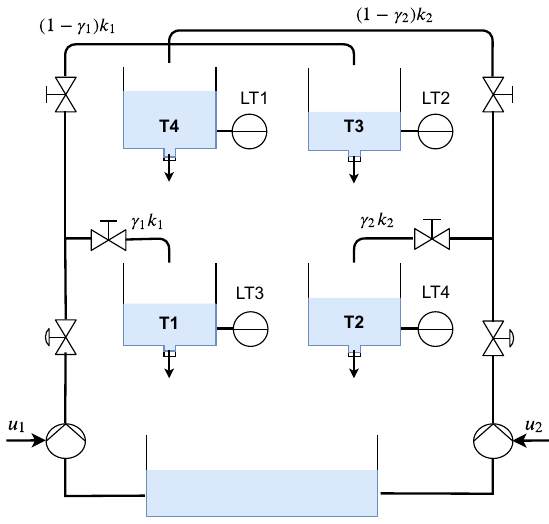
Figure 2. Four tank plant